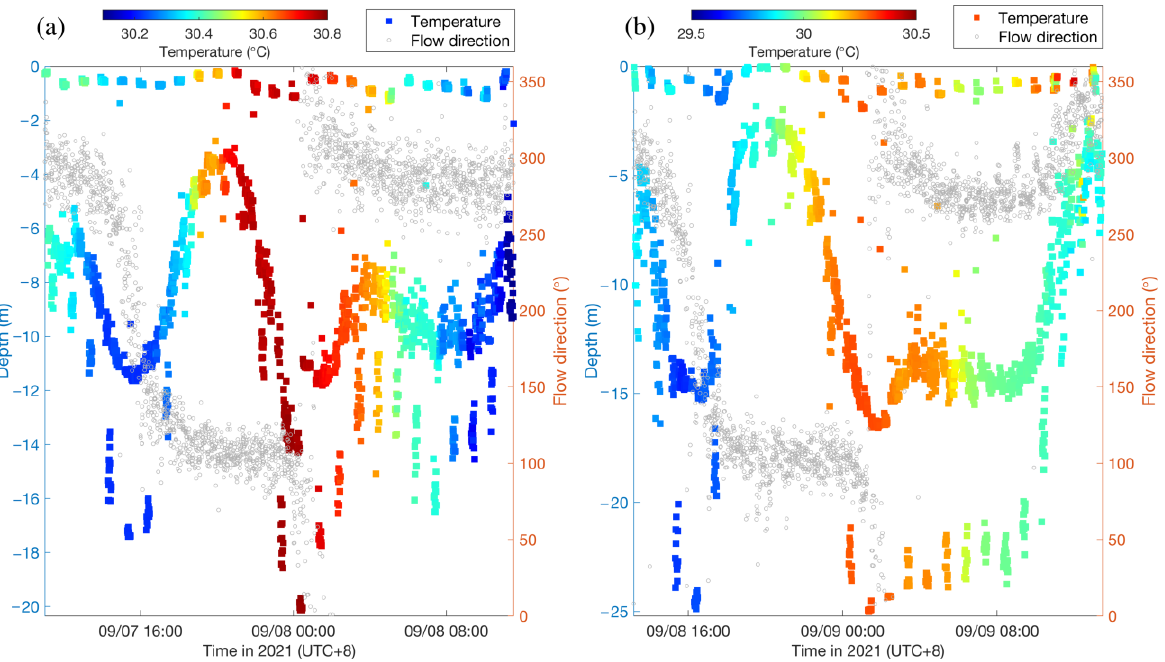
Figure 7. Cruise Observations of water temperature and current direction at stations Y1 ( a ) and Y2 ( b ) in the late summer of 2021, respectively.